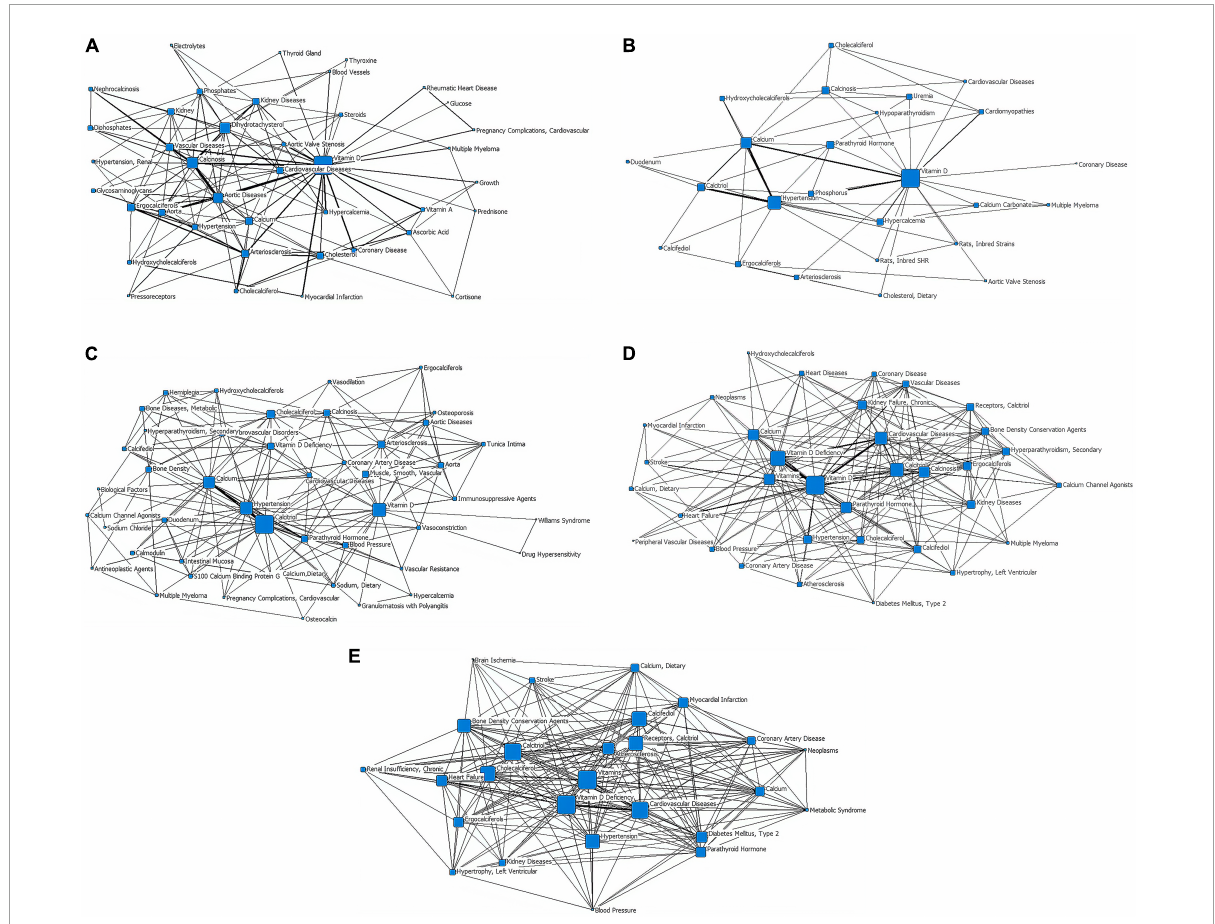
FIGURE3 Social network of core subject terms of “vitamin D AND cardiovascular disease” in the PubMed database before December 2020. (A) 1979. (B) 1980-1989. (C) 1990-1999. (D) 2000-2009. (E) 2010-2020.